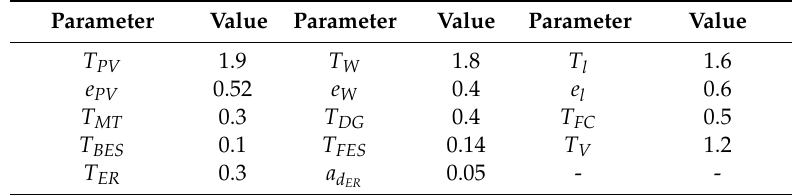
Table 1. Typical parameters for devices in energy internet (EI)